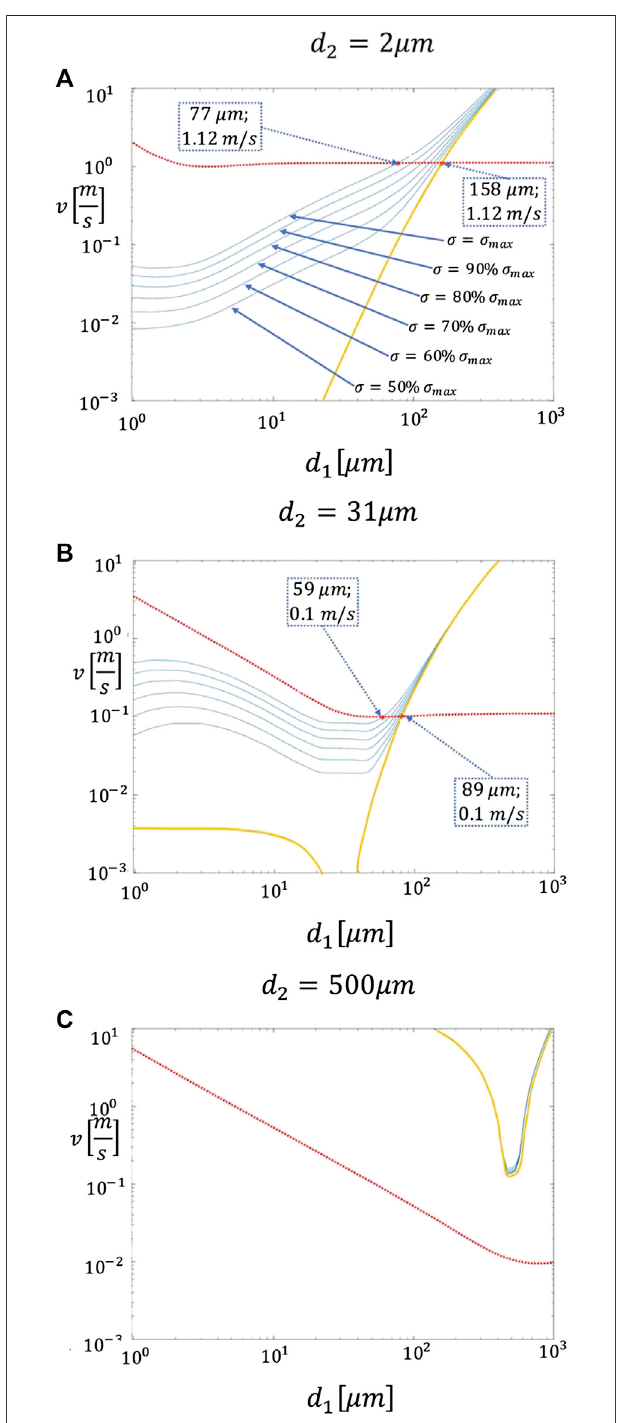
FIGURE 2 | Sticking velocity and relative velocity as a function of diameter for couples of objects colliding at 10 km and characterised by a density of 2500 kg / m 3 and a surface energy of 20 mJ / m 2 . The diameter of FIGURE 2 | represents a different value of the surface charge. Surface object 1 (d1) is plotted on the x-axis. Figures (A) , (B) , (C) are relative to charges of (50% σ max ; 60% σ max ; 70% σ max ; 80% σ max ; 90% σ max ; 100% σ max three differentdiametersofthe second object (2 μ m, 31 μ m and 500 μ m). Red are considered). The yellow lines represent the collision velocities between dashed lines represent the critical velocity for each couple of objects. Blue neutralparticles. Thevaluesforthediametersandofthevelocitiesinthelabels lines represent the relative velocity between charged objects. Each blue line are relative to the intersection points between the critical velocity and the ( Continued ) relative velocities for both neutral and fully charged